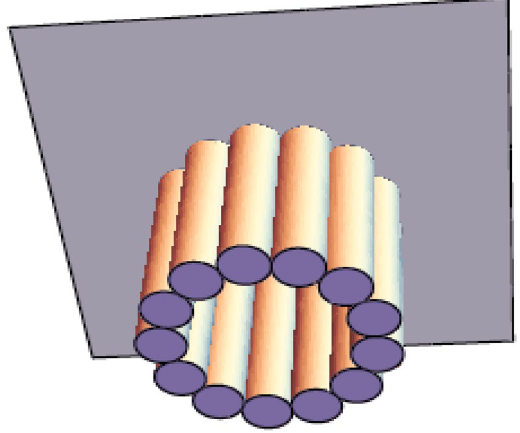
Figure 3. A schematic diagram of a multi-stranded filament with microtubule-like